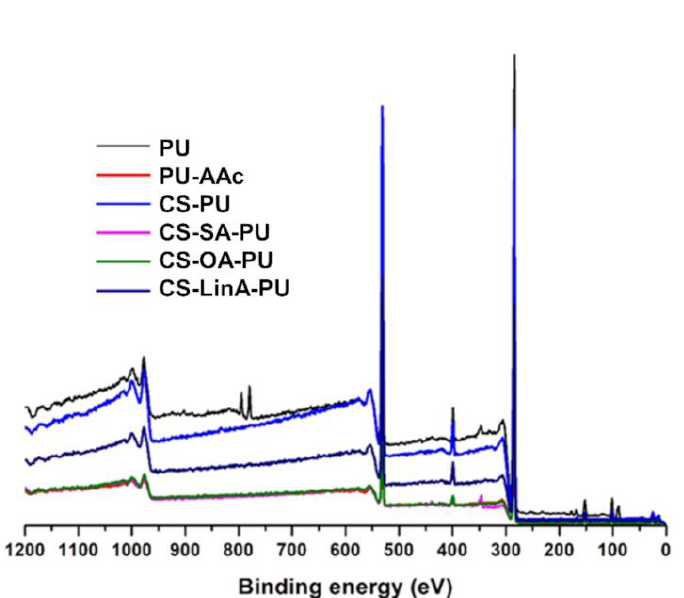
Figure 6. X-ray photoelectron spectroscopy wide scan of untreated and coated PU stents.